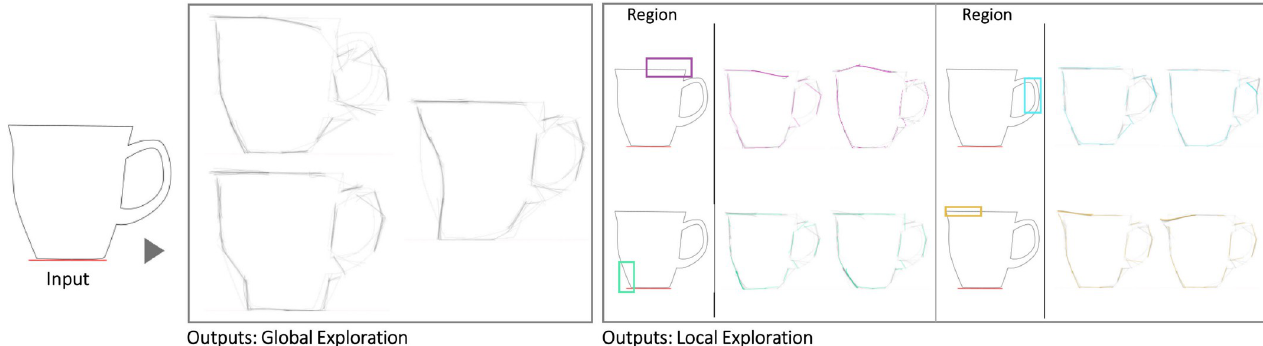
Fig 8. Some of the Global and Local shape variations generated with Shapi for the conceptual exploration of a coffee mug. The Seed is based on the silhouette of a design by Dunoon [87].